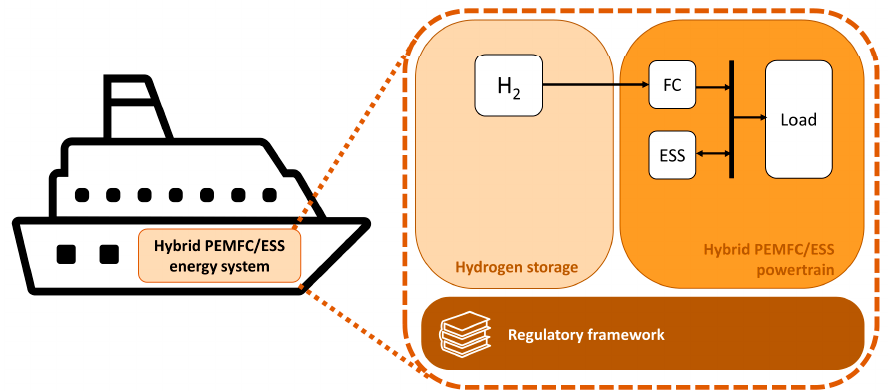
Figure 2. Simplified schematic of this paper’s object and delimitations.